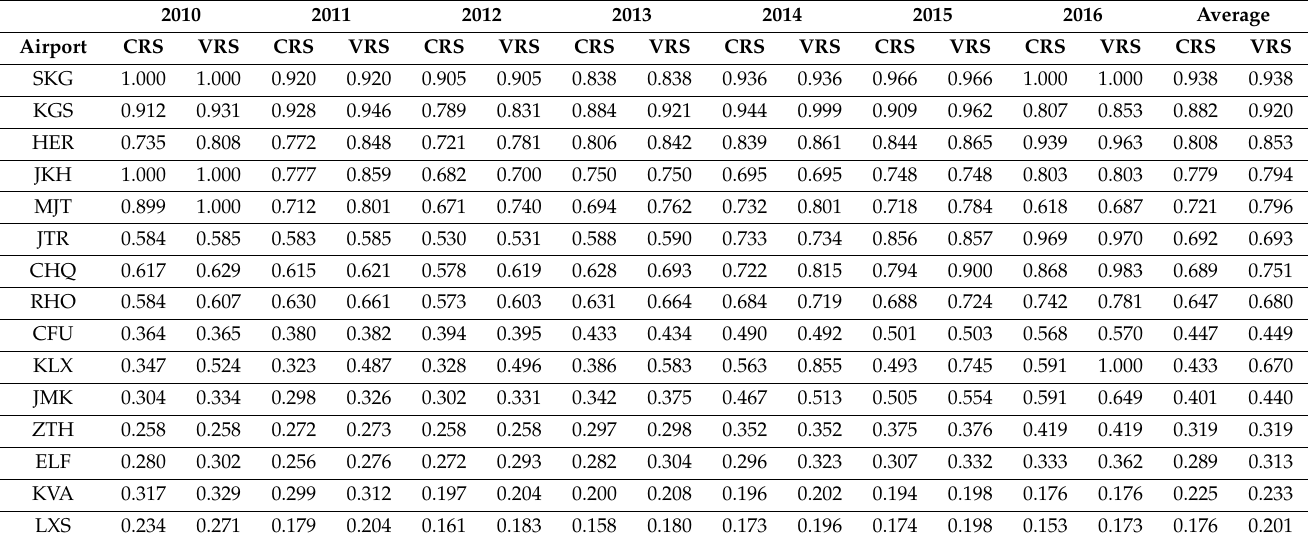
Table 5. Bootstrapped DEA efficiency scores for the study airports